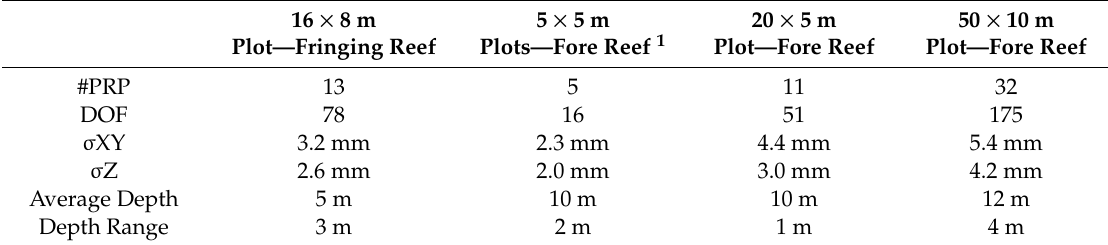
Table 1. Moorea Island Digital Ecosystem Avatar (IDEA) coral reef monitoring. Shown are average standard errors in planimetry ( σ XY) and height ( σ Z) for the primary control network in free network solutions. The number of measured primary reference points (#PRP), degree of freedom (DOF), average depth and depth range values are also